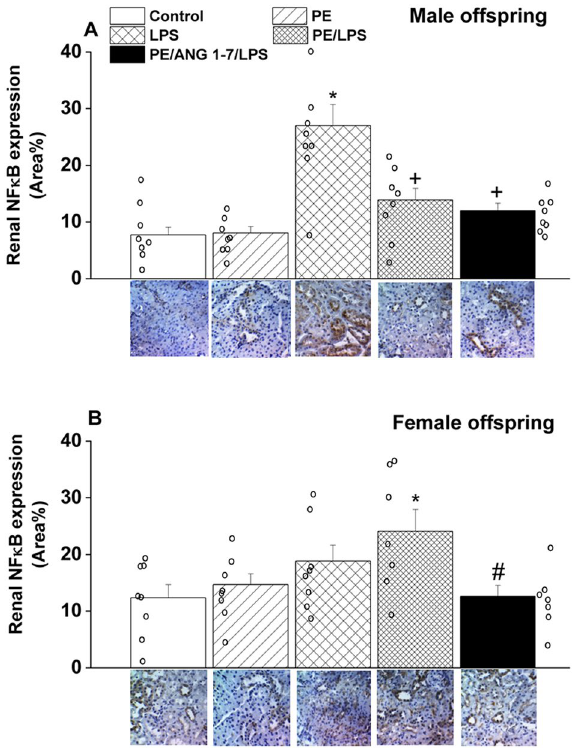
Figure 8. Effect of PE and /or LPS on immunohistochemical protein expression of NFκB in renal tubular tissues of male ( A ) and female offspring ( B ). The influence of prenatal administration of Ang1-7 is also shown. The One-way ANOVA followed by the Tukey’s post hoc was utilized to measure statistical significance. Values are expressed as means ± S.E.M of 6–7 observations. *P < 0.05 vs. “Control”, + P < 0.05 vs. “LPS”, #P < 0.05 vs. “PE/ LPS” values. Representative images for immunostained sections from the renal tubular tissues are also